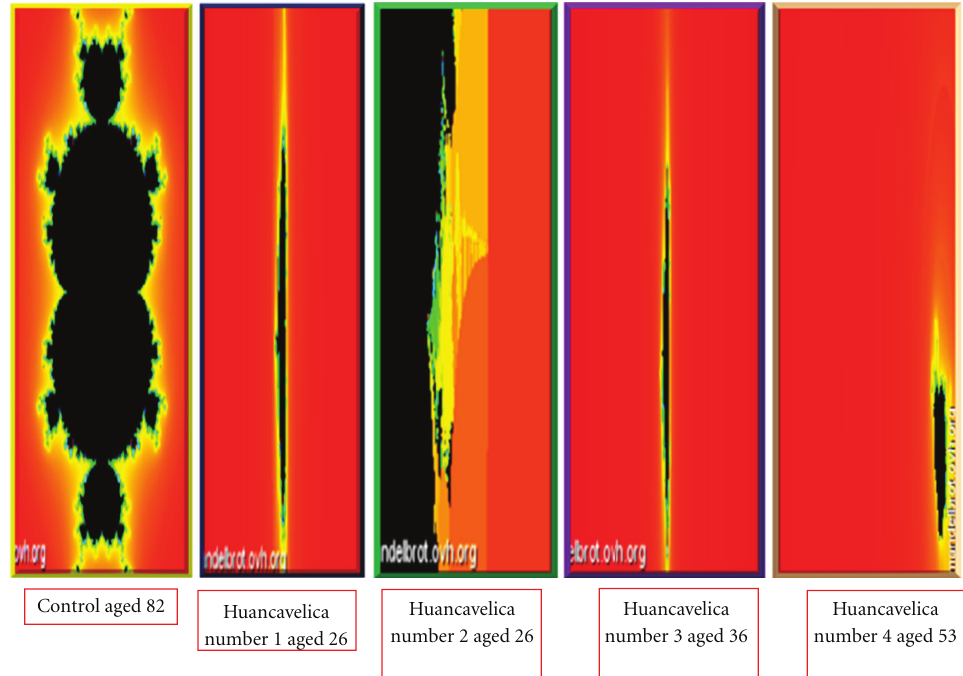
Figure 7: Mandelbrot sets showing the complex interactions between Hg and biologic rhythms. Notable is the lack of structural features in the sets derived from all Huancavelica residents in keeping with the lack of variability found in the power spectra derived from the hydrogen isotope ratios of the same individuals (see Figure